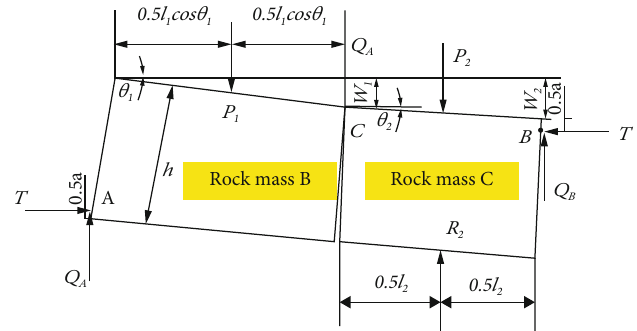
Figure 3: Load analysis of “ short masonry beam ” structural model of overlying